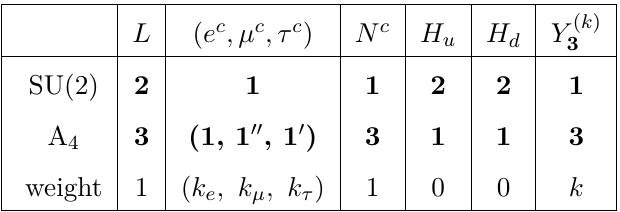
Table 1 . Representations and weights for superfields and relevant modular forms of weight k . three generations of the left-handed lepton doublets are assigned to be an A the right-handed charged leptons e c , µ c , and τ c are A The three generations of the right-handed Majorana neutrinos are also assigned to be an A triplet N c [128]. The weight of the superfields of left-handed leptons is fixed to be 1 as a 4 reference value. The weight of right-handed neutrinos is also taken to be 1 in order to